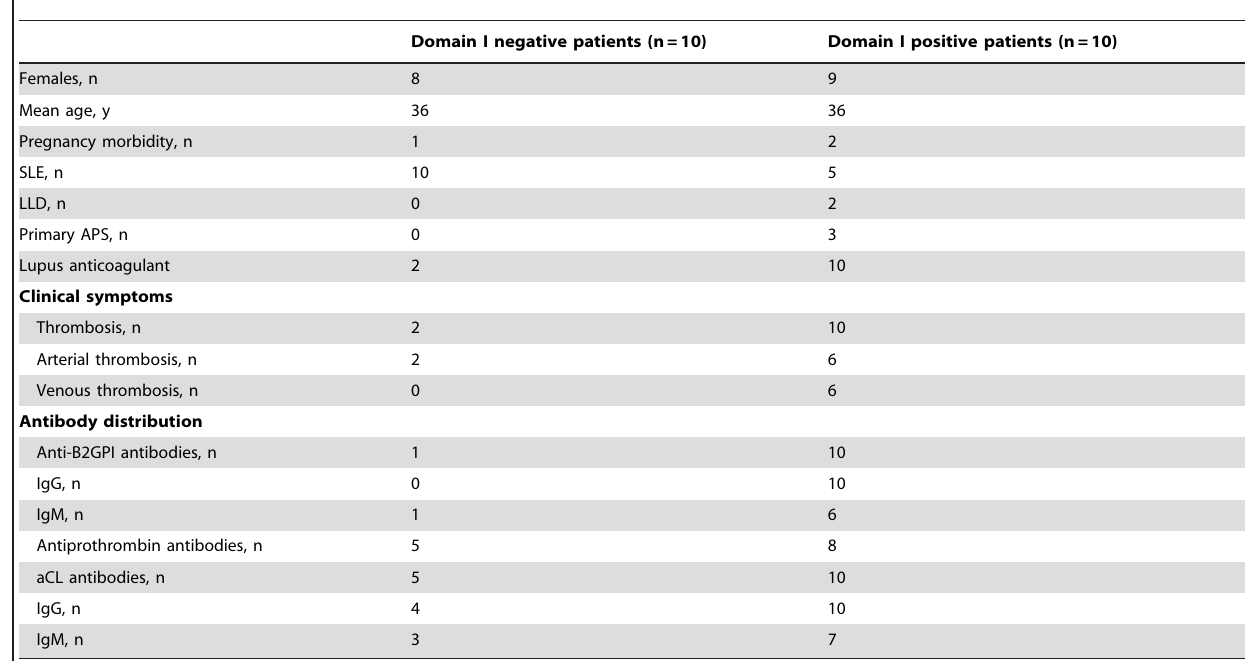
Table 1. Clinical and serological characteristics of the first patient